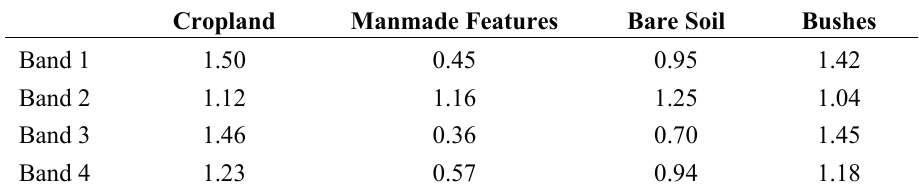
Table 3. The correctors of different land cover types from Band 1 to Band 4. Cropland Manmade Features Bare Soil